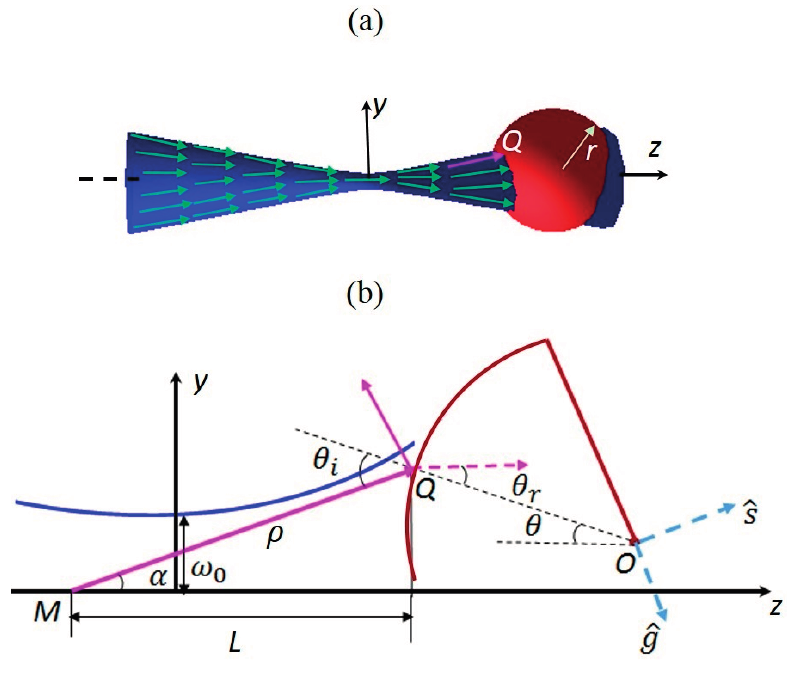
Figure 4. ( a ) An overall view of a single beam acoustic tweezers. Blue hyperbolic space represents the focused acoustic beam. Green vectors denote the wave propagation direction. Pink arrow is an individual incident ray hit on the target particle. Red ball is the target particle; ( b ) 2D zooming geometry for the analysis of the radiation force when a sphere located at the arbitrary location. Blue line represents the acoustic beam. The incident ray assumed from point (cid:1839) with angle α to the beam axis z hits the spherical particle (red line) at point Q . The absolute distance between (cid:1839) and (cid:1843) is (cid:2025) , which is also the radius of the spherical wave front. L is the axial distance between (cid:1839) and (cid:1843) . (cid:1841)(cid:1843)(cid:4652)(cid:4652)(cid:4652)(cid:4652)(cid:4652)(cid:4652)(cid:3377) and z axis has angle (cid:2016) to each other. (cid:2016) and (cid:2016) indicate the incident angle and refractive angle at the (cid:2919) (cid:2928) interacting point (cid:1843) respectively. (cid:1871)̂ and (cid:1859)(cid:3548) are the unit vectors representing the directions